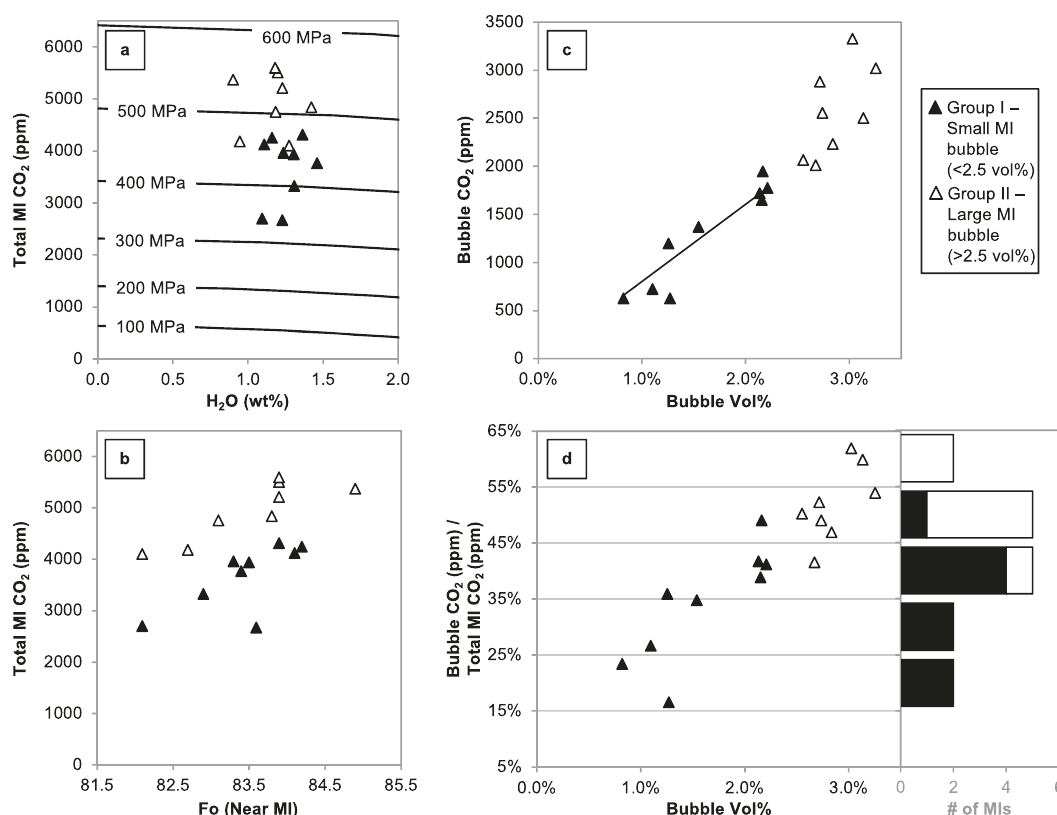
Fig. 2 CO 2 contents of Sunset Crater MIs and bubbles. Filled symbols are MIs with bubbles <2.5 vol% (Group I) and open symbols are MIs with bubbles >2.5 vol% (Group II). a H 2 O – CO 2 of MIs, including all CO 2 from MI bubble. Curves are isobars from ref. 32 . b Total MI CO 2 vs. Fo content of the olivine host measured next to the MI. c Bubble CO 2 content vs. bubble vol%; linear trend is fi t through samples with bubbles <2.5 vol%. d Percentage of total MI CO 2 content contained in MI bubble vs. bubble vol%. Data are also shown as a histogram of the percentage of total MI CO 2 contained in the bubble. Error from FTIR analysis is 10% for H 2 O and 5% for CO 2 , while the error in the total CO 2 content from bubble calculations is 5%. Error in MI bubble vol% is 15% (i.e., 0.3 vol% error for a 2 vol% bubble). See “ Methods ” for details on error